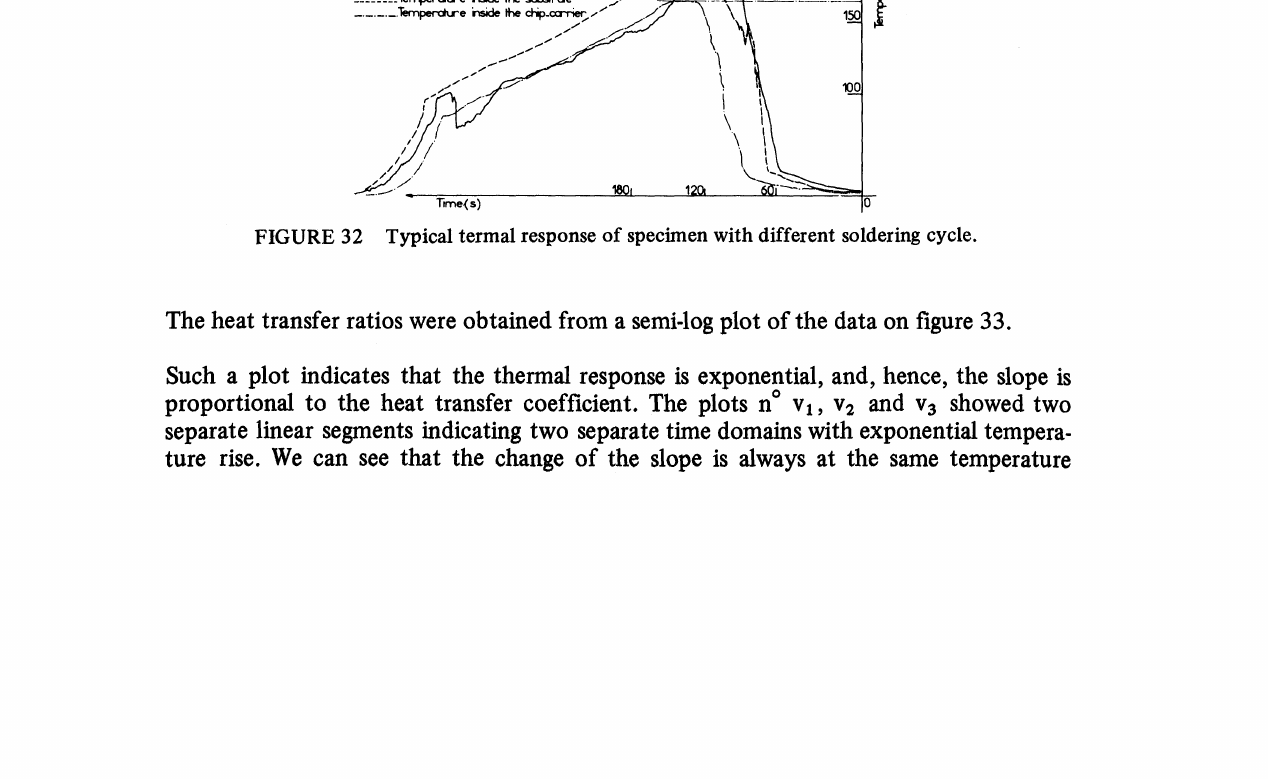
FIGURE 32 Typical termal response of specimen with different soldering